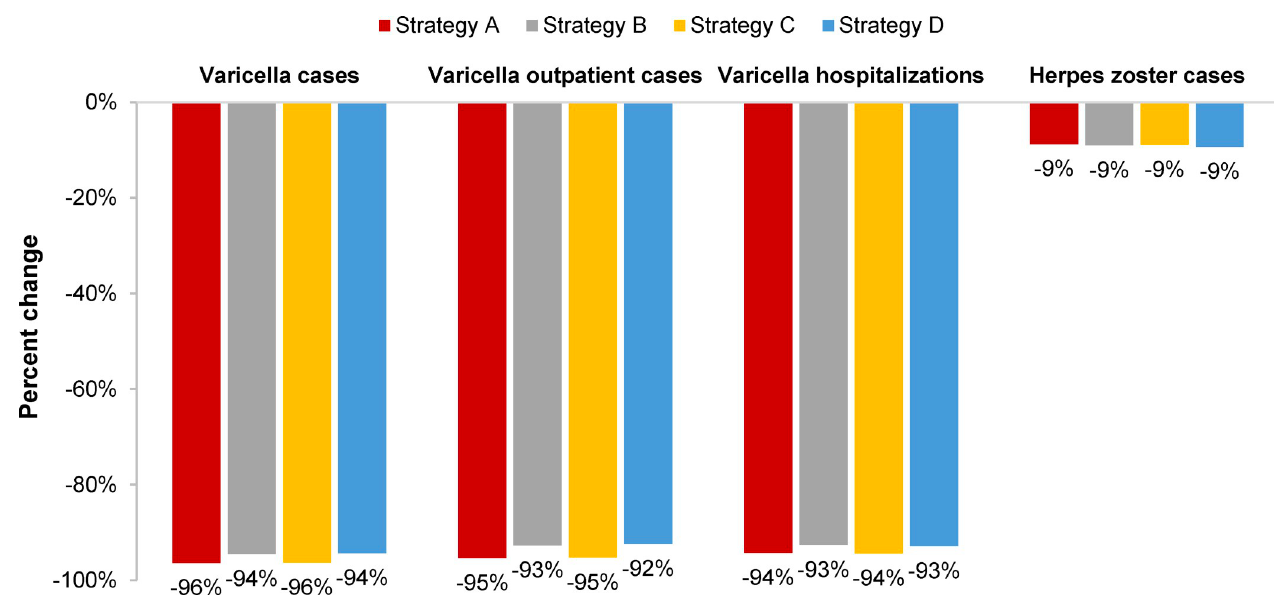
Fig 2. Percent change in varicella and herpes zoster health outcomes, compared to no vaccination, over 50 years, by vaccination strategy. Health outcomes with strategies E and F were the same as for strategies C and D, respectively. Strategy A : V-MSD (12 months) + V-MSD (15 months); Strategy B : V-GSK (12 months) + V-GSK (15 months); Strategy C : V-MSD (15 months) + V-MSD (48 months); Strategy D : V-GSK (15 months) + V-GSK (48 months); Strategy E : V-MSD (15 months) + MMRV-MSD (48 months); Strategy F : V-GSK (15 months) + MMRV-GSK (48 months).